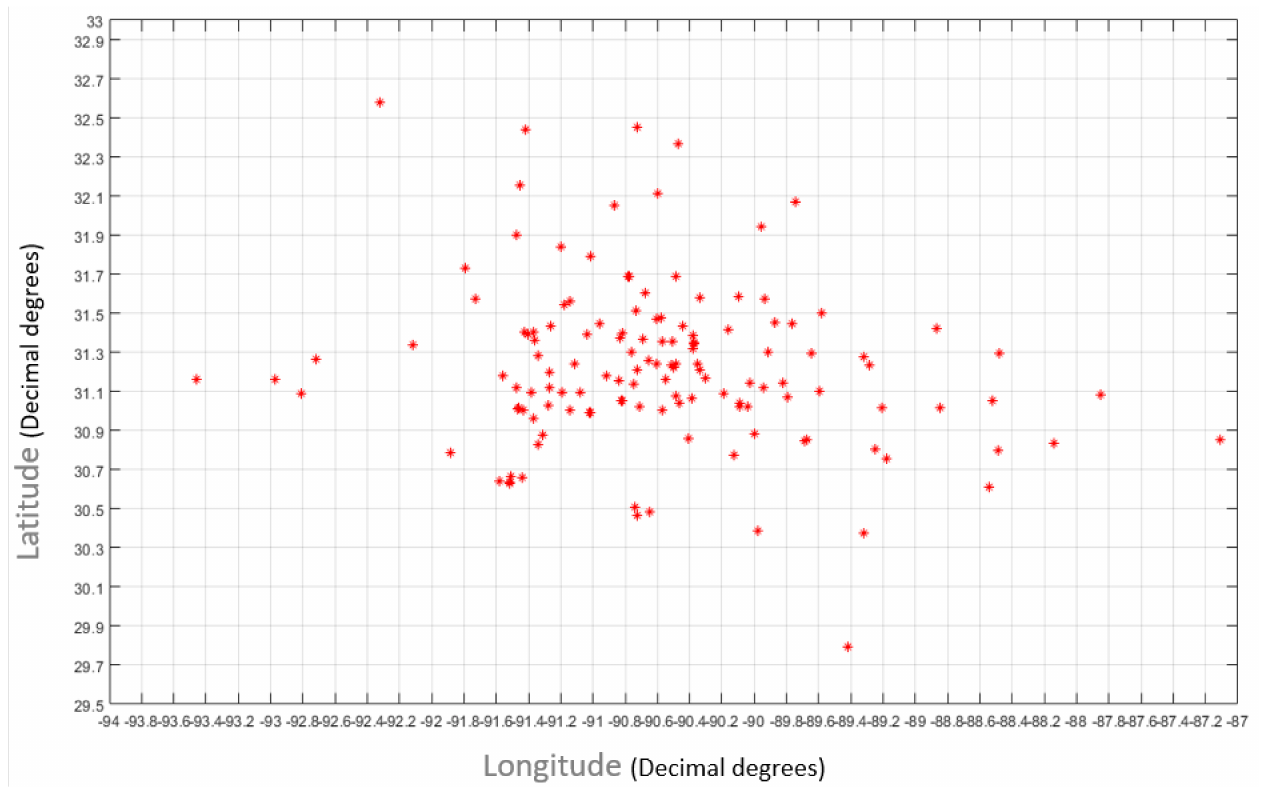
Figure 3. Distribution of spatial measurements on a rectangular grid. Table 1. Statistical measures of TOC wt% data. z min : minimum value; z max : maximum value; z 0.50 :